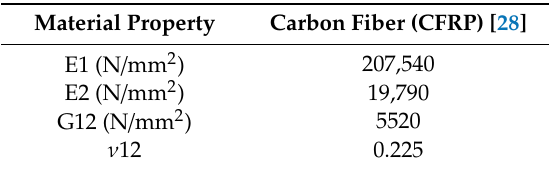
Table 3. Material properties of boron / epoxy